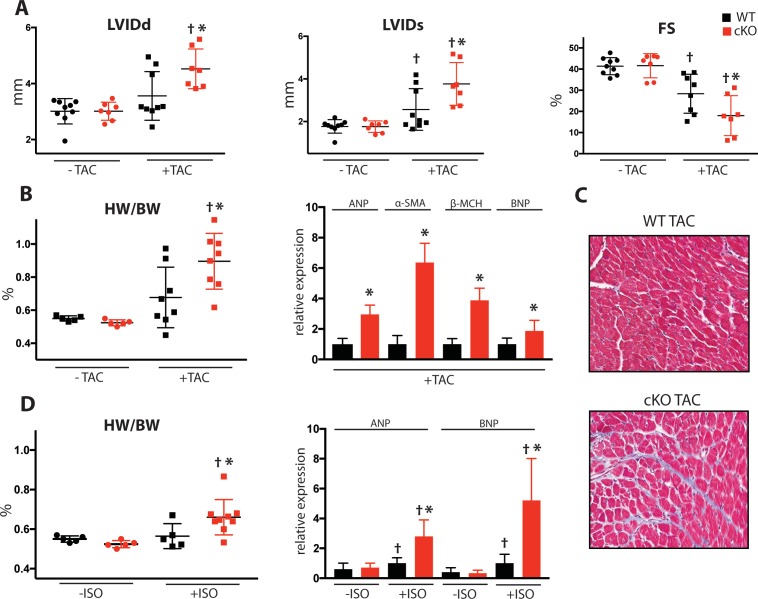
Fam20C cKO mice develop heart failure following induced pressure overload.(A) Echocardiographic measurements for baseline (2 months old) mice and after 4 weeks of TAC (n = 7–9) of LVIDd, LVIDs, and LV FS. (B) Heart weight to body weight ratios (n = 5–9) (left). RT-qPCR of cardiac fetal gene markers following TAC (n = 3) (right). (C) Representative microscopic view of Masson’s Trichrome stained (40x magnification) cardiac sections following TAC (n = 3 mice). (D) Mice were subjected to 2 weeks of chronic Isoproterenol (ISO) infusion (n = 5–9). Heart weight over body weight ratio (n = 5–9) (left) and RT-qPCR of cardiac fetal gene markers (n = 3) (right). Data are represented as the mean ±SEM. *p < 0.05, **p < 0.01, for WT v. cKO; † p < 0.05 for TAC or ISO treatment by Student’s t test.